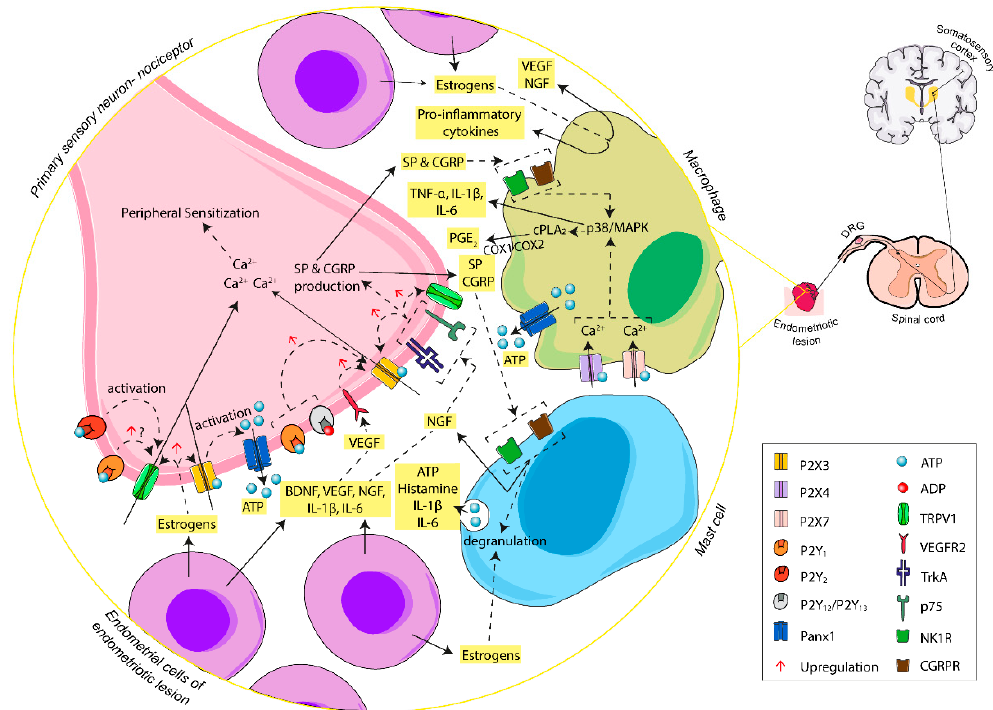
Figure 2. Schematic summary of the involvement of ATP, through activation of P2X and P2Y receptors, in the initiation of endometriosis-associated pain. In the endometriotic lesion, ATP, released by di ff erent cell sources, carries out Ca 2 + influx via P2X3 receptor activation at the endings of primary sensory neurons, triggering a cascade of changes that increase the excitability of a ff erent sensory neurons. The activation of P2Y receptors potentiates the action of P2X3 receptor and TRPV1, triggering induction of nociception and the maintenance of overstated pain. Moreover, ectopic endometrial cells and inflammatory cells of the lesion release inflammatory mediators that boost nerve sensitization and promote the inflammatory state typical of women with endometriosis. Abbreviations: adenosine triphosphate, ATP; adenosine diphosphate, ADP; pannexin-1, Panx1; brain-derived neurotrophic factor, BDNF; neurotropin nerve growth factor, NGF; tyrosine kinase A receptor, TrkA; p75 neurotrophin receptor, p75; vascular endothelial growth factor, VEGF; vascular endothelial growth factor receptor 2, VEGFR2; interleukin-1 beta, IL-1 β ; interleukin-6, IL-6; tumor necrosis factor alpha, TNF- α ; substance P, SP; neurokinin-1 receptor, NK1R; calcitonin gene-related peptide, CGRP; calcitonin gene-related peptide receptor, CGRPR; transient receptor potential vanilloid-1 channel, TRPV1; p38 mitogen-activated protein kinases, p38 / MAPK; cytosolic phospholipase A2, cPLA 2 ; prostaglandin E2, PGE2; cyclooxygenase-1 and -2, COX-1 / COX-2; dorsal root ganglia, DRG.